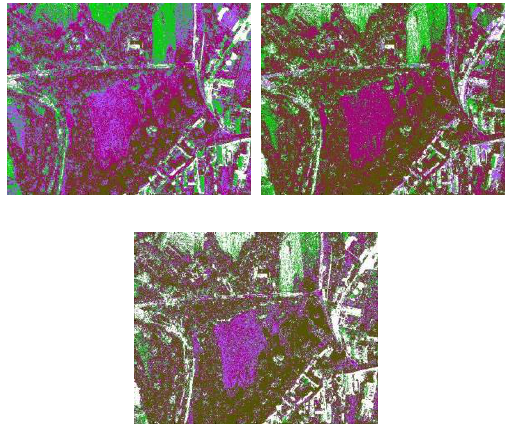
Figure 6: Reclassification of reconstructed image with not centered oblique Procrustes method. In order ML, KM, SOM classifier